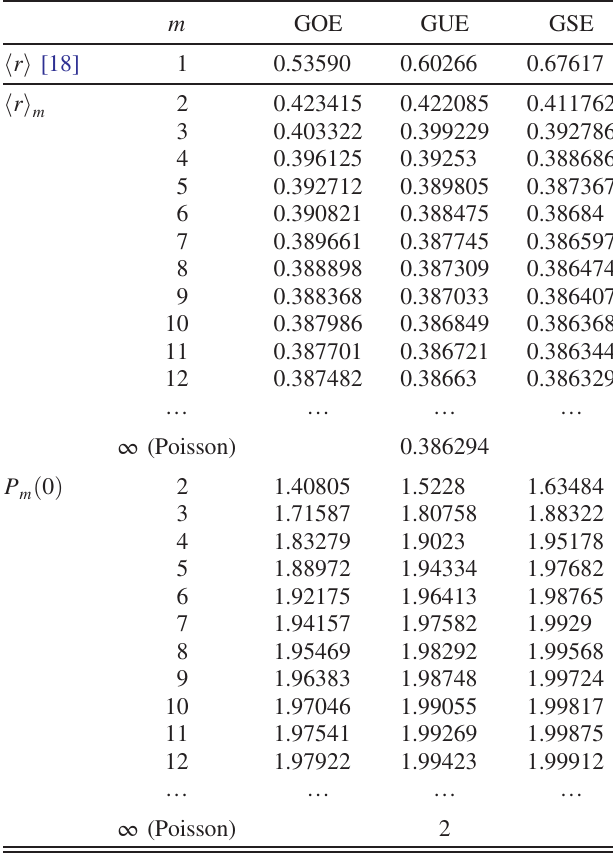
TABLE I. Values of averages h r i and probability at r ¼ 0 for m blocks, obtained from the surmise approach in Sec. III. The value for m ¼ 1 is taken from Ref. [18]. Values for h r i Table II in Sec. III